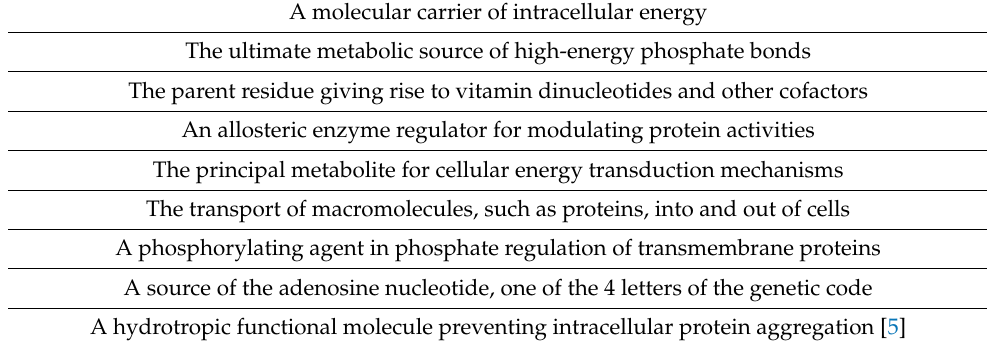
Table 1. Functions of